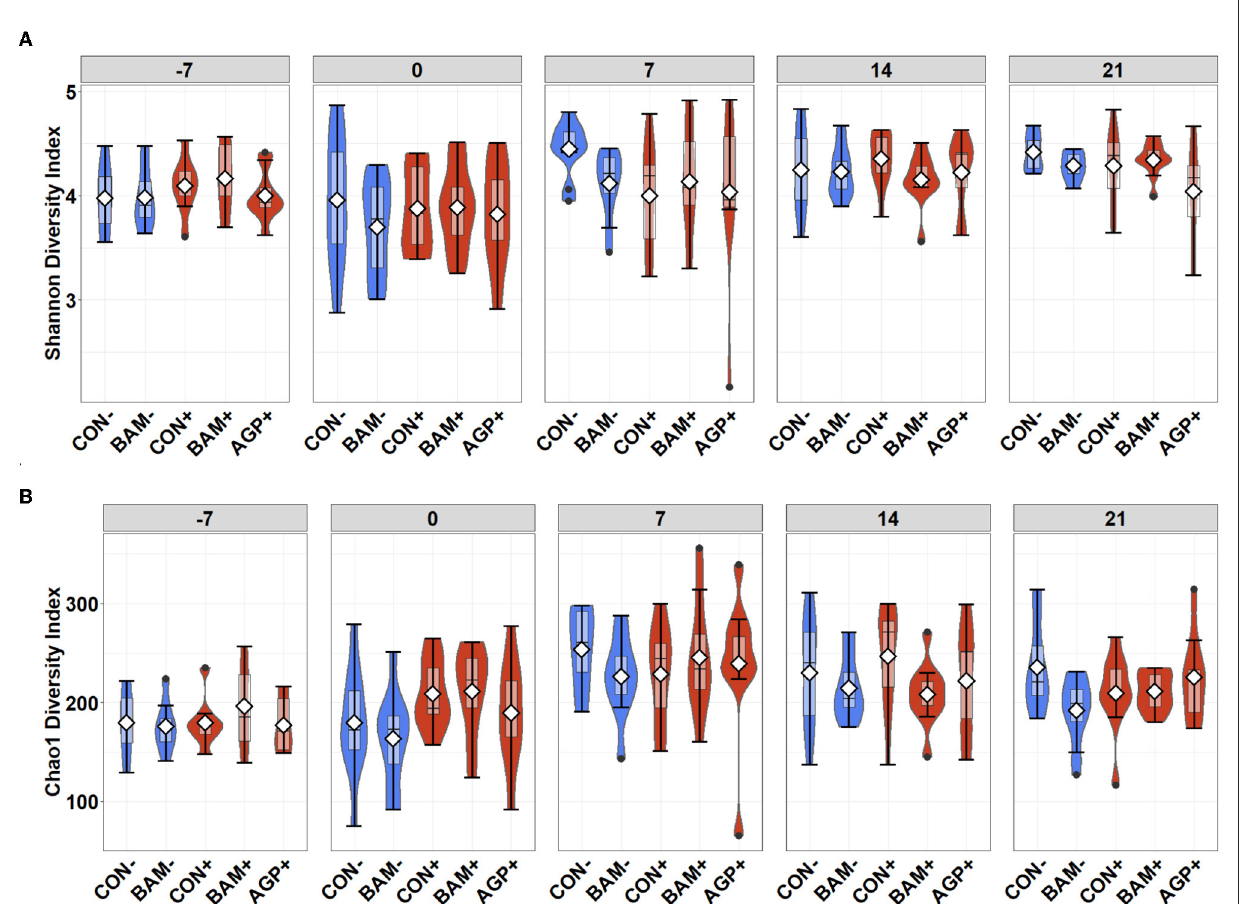
FIGURE4 Alpha diversity as indicated by Shannon (A) and Chao1 (B) indices in feces of weaned pigs fed with control (CON) diet or diets supplemented with Bacillus amyloliquefaciens (BAM), or antibiotics (AGP) at the beginning of the experiment (day − 7), the first day of E. coli (ETEC) inoculation (day 0), and days 7, 14, and 21 post-inoculation. No difference was observed in Shannon (A) and Chao1 (B) indices among treatments. Violin plots are colored whether not infected (blue) or infected with E. coli (red). Data are expressed as mean (diamond) ± SEM.